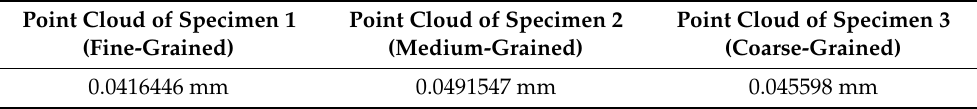
Table 3. RMSE for the point clouds using 50,000 random sample